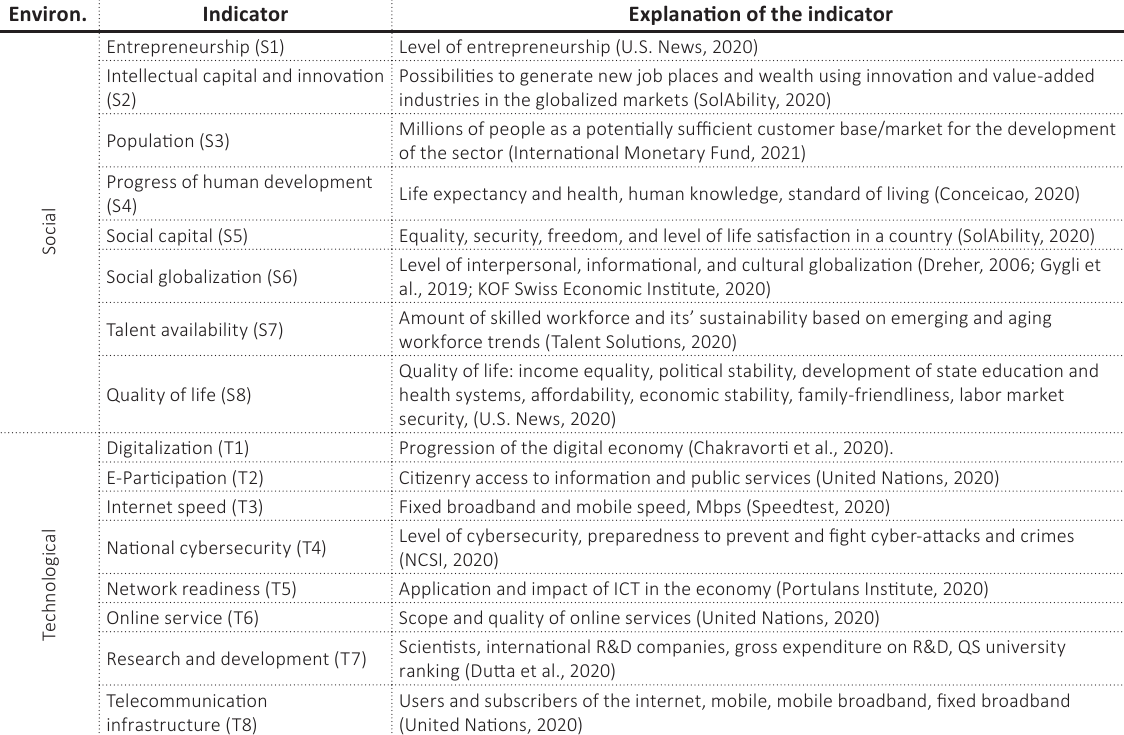
Table A1 (cont.). Assessment tool for FinTech sector environment based on PEST analysis of FinTech sector external environmental